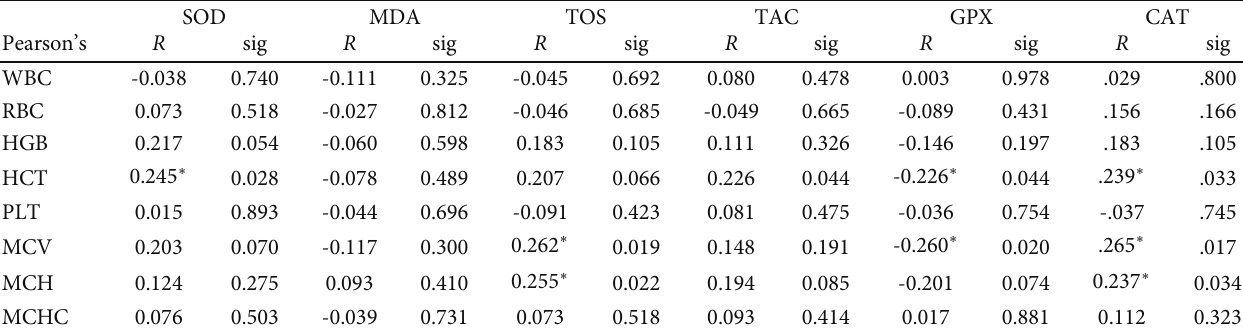
Table 6: Correlation between oxidative stress parameters and haematological indices. SOD